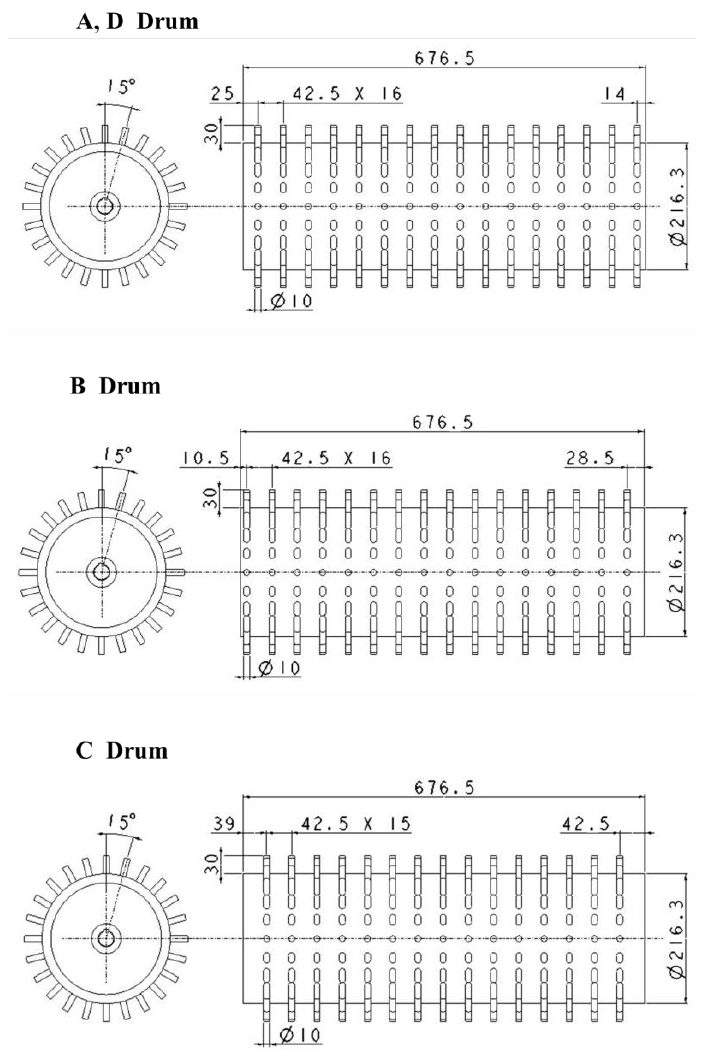
Figure 3. Shape and dimensions of each rotating drum and cylindrical brush teeth. A Drum: the first drum installed on shaft 1; B Drum, C Drum, D Drum: the followed drum in order by shaft 2, shaft 3, and shaft 4.